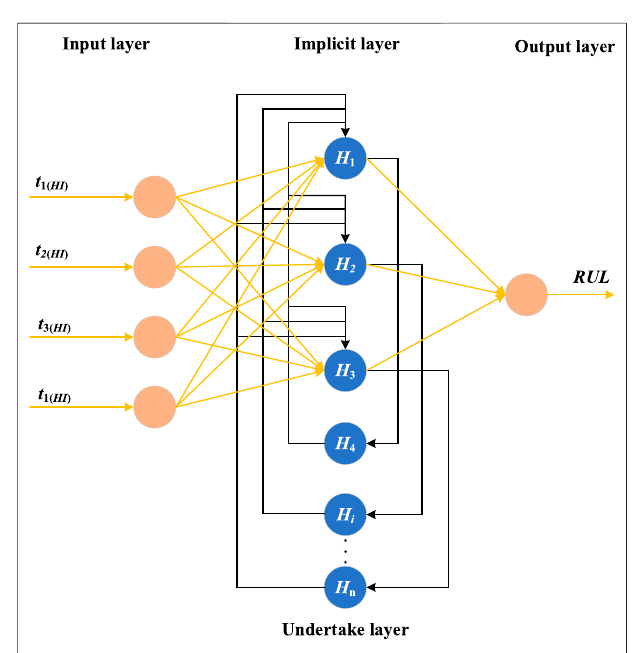
FIGURE 3 | Schematic diagram of Elman training